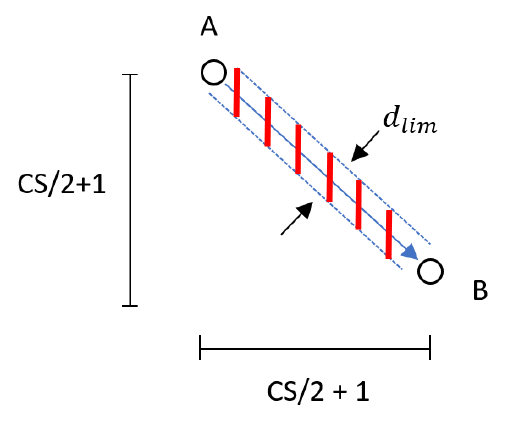
Figure 4. Graphical representation of the safety corridor assumed in the collision avoidance constraint. In our simulations, we use d lim = 4